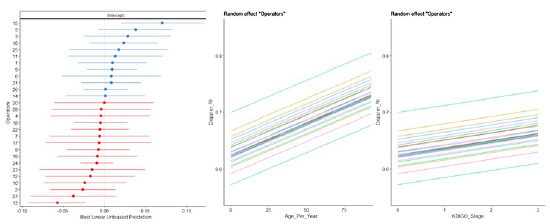
Fig. 1 Reporting change in RI according to operators after adjustment for confounders (one line per operator) F‑033 Echocardiographic follow‑up of right ventricular dysfunction